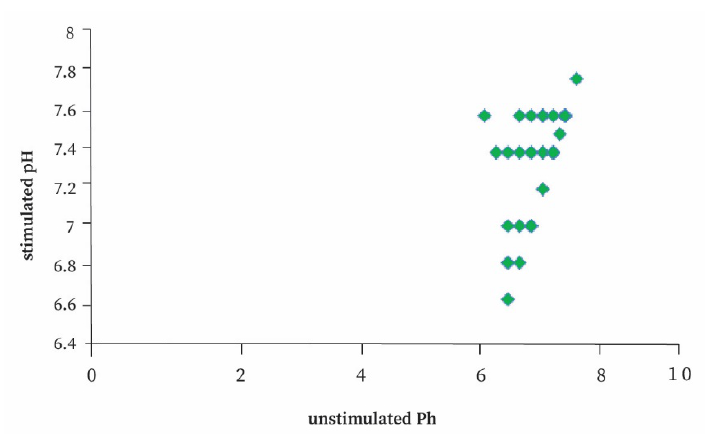
Figure 7. Correlation between DMFT (%) and unstimulated pH.